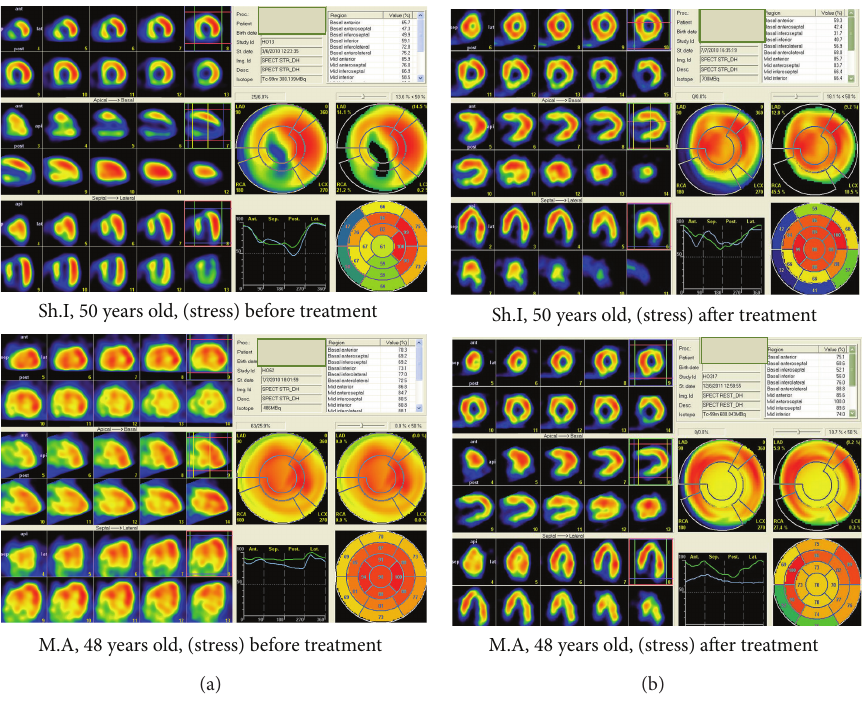
Figure 4: The areas that benefit from myocardial revascularization after single cell therapy in two patients, carried out by myocardial scintigraphy (post stress condition) before treatments and after 9 months (black, no perfusion; blue-green-yellow-red, increasing perfusion).